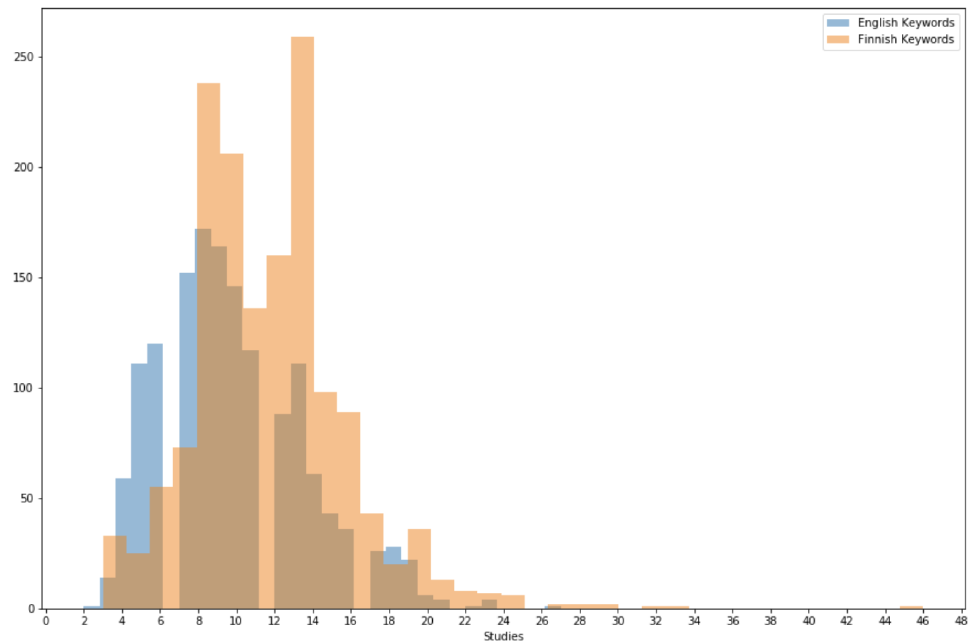
Figure 3. Keyword Frequency Distribution for the English and Finnish studies’ metadata.